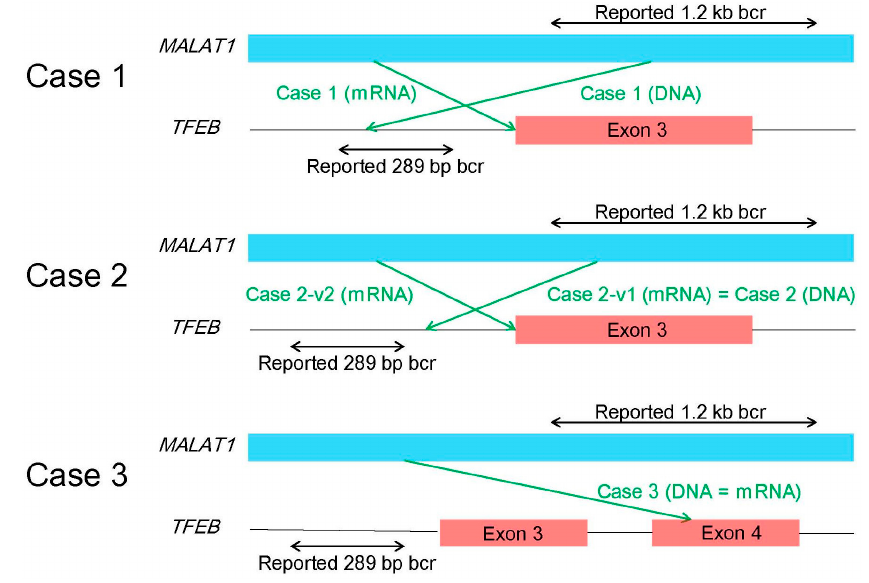
Figure 3. Schematic representation of each fusion pattern for three cases (Cases 1 ‒ 3) of t(6;11) renal cell carcinoma. bcr: breakpoint cluster region.